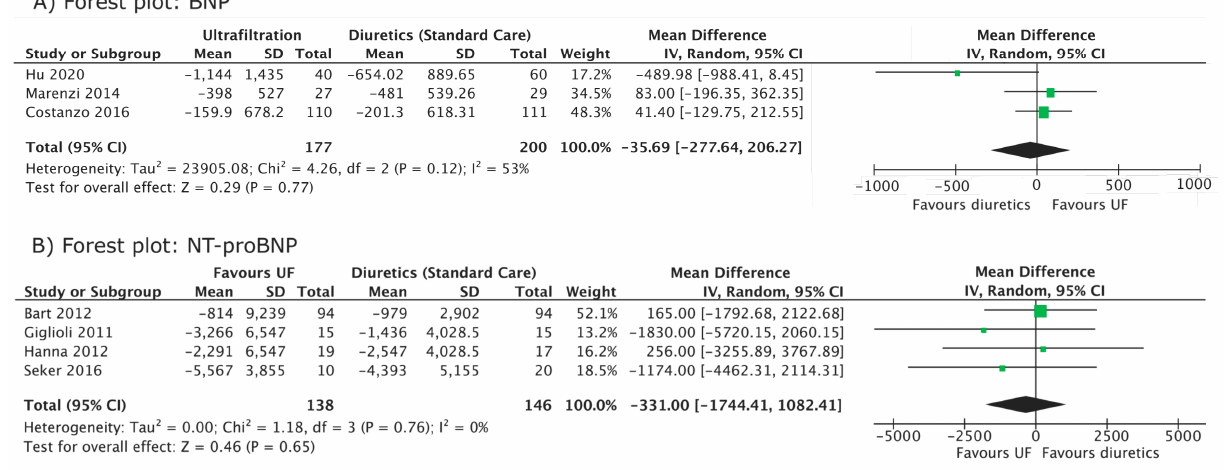
Figure 2. Forest plot of cardiac biomarkers (BNP and NT-proBNP). ( A ) Forest plot comparing the mean difference in BNP (change from baseline) between ultrafiltration and diuretic groups. ( B ) Forest plot comparing the mean difference in NT-proBNP (change from baseline) between ultrafiltration and diuretic groups. Individual studies are represented by their author and year of publication in the first table column. Mean differences and 95% confidence intervals are presented for